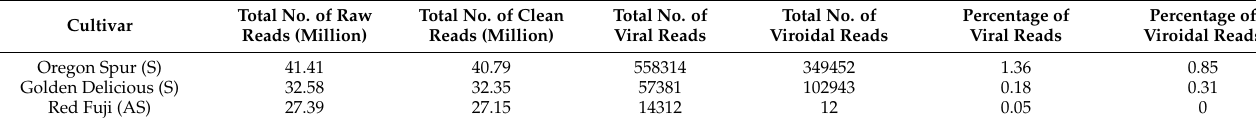
Table 1. Read statistics and percentage of virus and viroid reads via next-generation sequencing Illumina Hiseq 2500 from three apple cultivars.